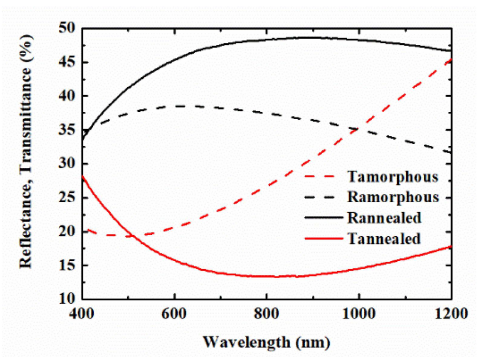
Figure 2. Reflectance and transmittance spectra for the amorphous and annealed zones of the thin